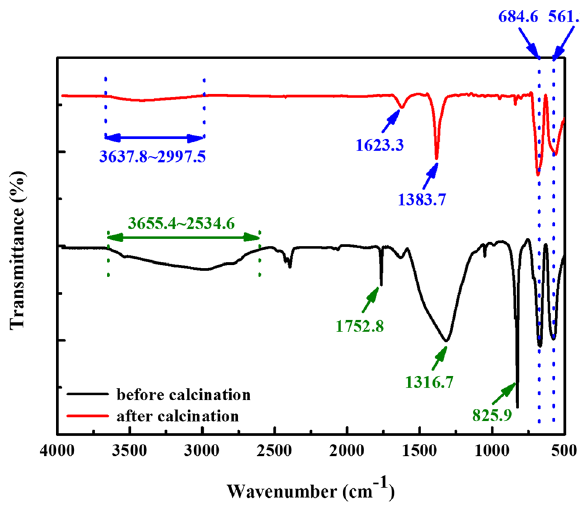
Figure 2. FT-IR spectra of the ZnCo 2 O 4 NPs before and after calcination.